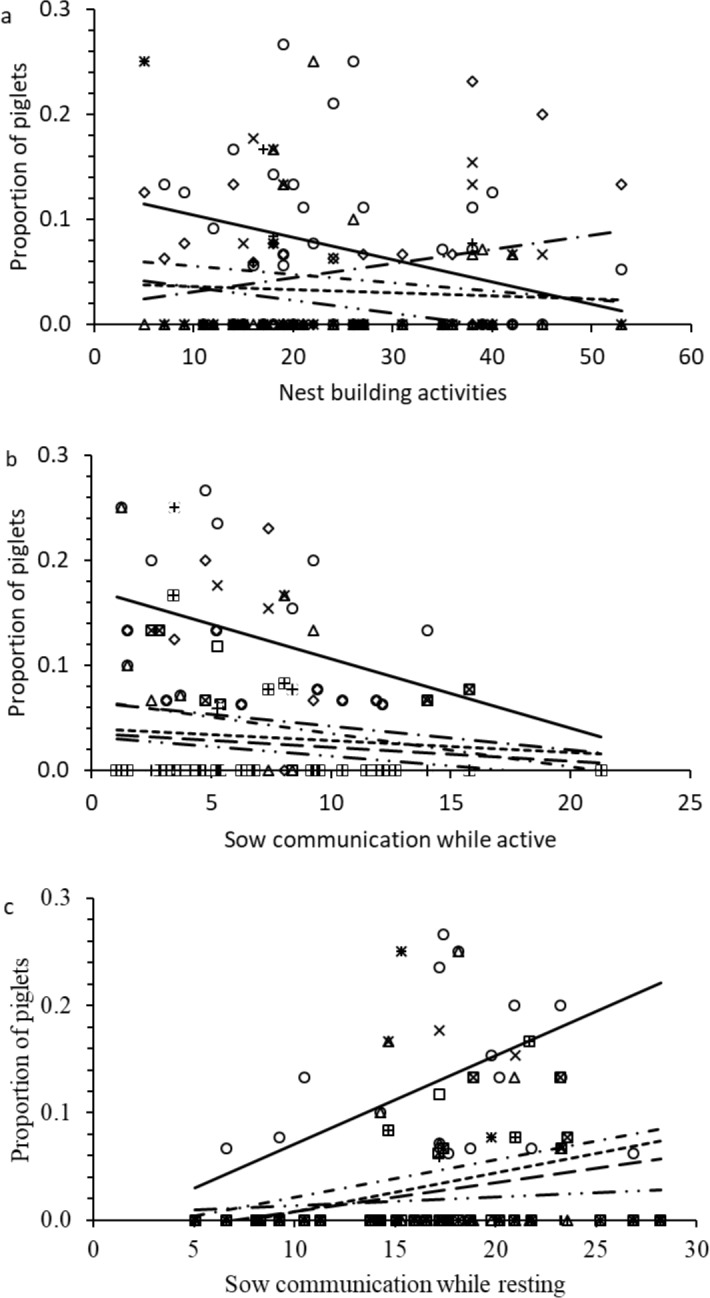
Proportion of piglet mortality in relation to sow behavior.(A) Piglet mortality (stillborn (χ2
1, 37 = 45.1; P < 0.001), starvation (χ2
1, 37 = 8.4; P = 0.004), overlying (χ2
1, 37 = 4.5; P = 0.034), overlying without milk (χ2
1, 37 = 30.7; P < 0.001), and other causes (χ2
1, 37 = 24.8; P < 0.001) in relation to sow nest building activities. (B) Piglet mortality (postnatal (χ2
1, 37 = 95.0; P < 0.001), starvation (χ2
1, 37 = 18.5; P < 0.001), overlying (χ2
1, 37 = 37.4; P < 0.001), overlying with milk (χ2
1, 37 = 25.1; P < 0.001), overlying without milk (χ2
1, 37 = 10.0; P = 0.002), and other causes (χ2
1, 37 = 43.8; P < 0.001) in relation to sow communication to piglets while active. (C) piglet mortality (postnatal (χ2
1, 37 = 66.1; P < 0.001), starvation (χ2
1, 37 = 83.9; P < 0.001), overlying (χ2
1, 37 = 44.2; P < 0.001), overlying with milk (χ2
1, 37 = 41.6; P < 0.001), and overlying without milk (χ2
1, 37 = 5.7; P = 0.017) in relation to sow communication to piglets while resting.